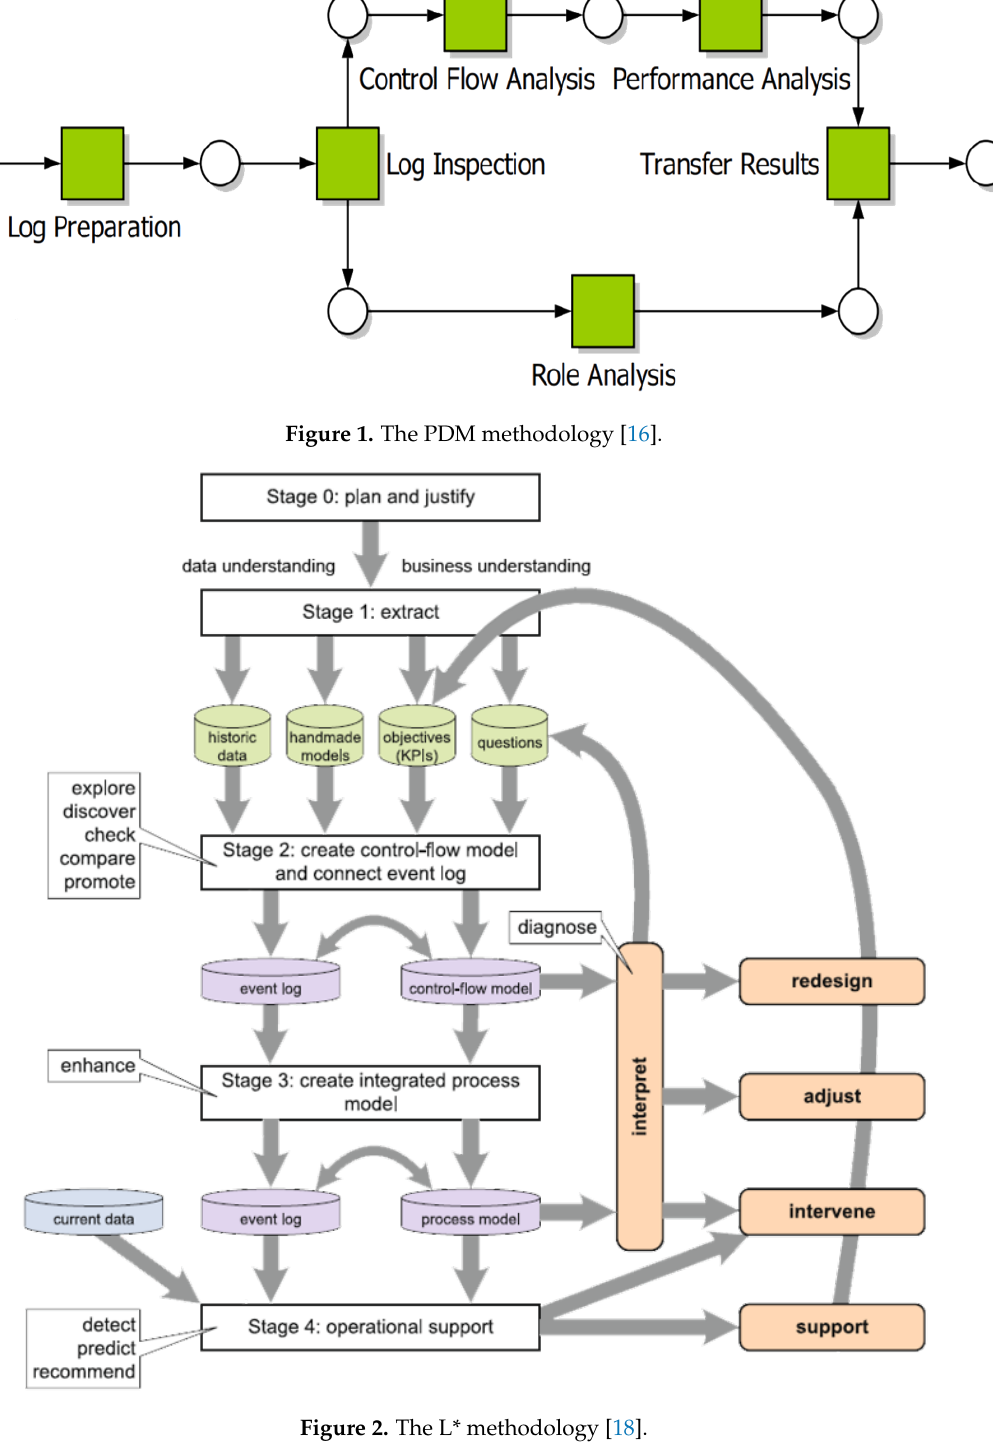
Figure 2. The L* methodology